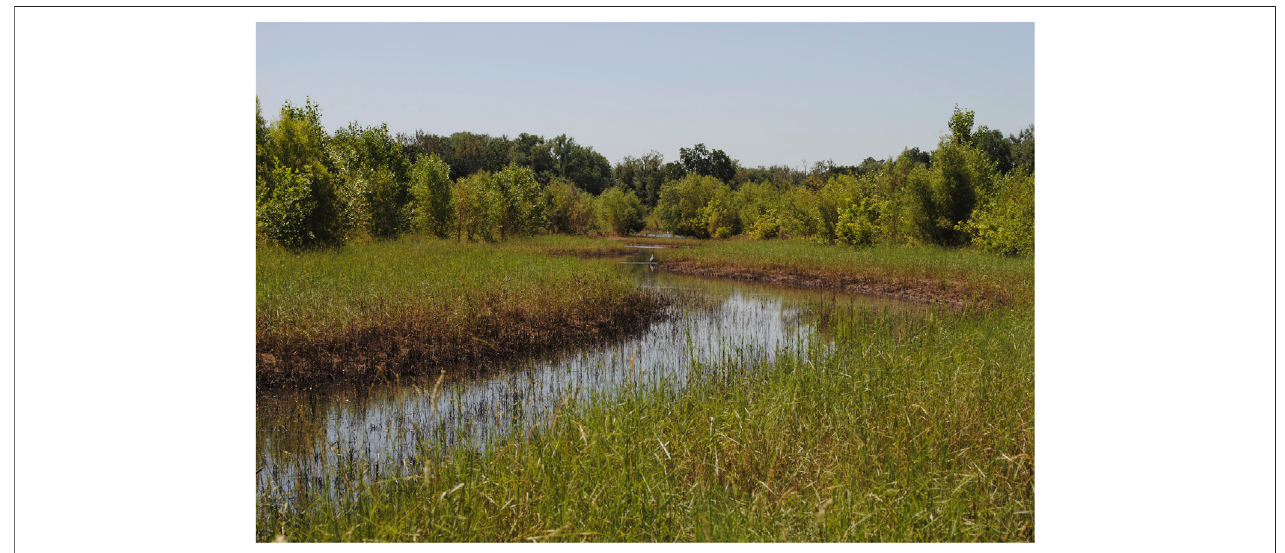
FIGURE 6 | Floodplain Swale in the restoration area of the Bear River Levee Setback project, 2016 (Courtesy of River Partners).